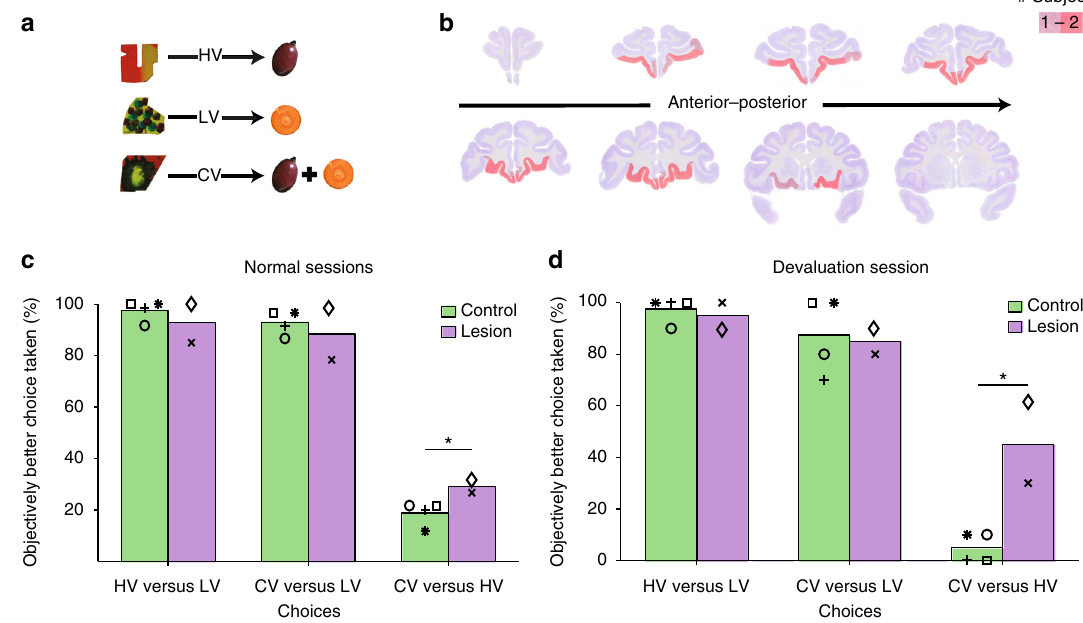
Fig. 1 Behavioral data — experiment 1. a Example stimulus-reward associations for HV, LV, and CV options. b Red shading indicates area of vmPFC/OFC lesion present in one or both animals. c Frequency of choosing objectively better of the two options. Controls (green bars) as well as lesioned animals (purple bars) preferred HV- to LV- stimuli and CV- to LV-stimuli. For the HV vs. CV decision, strikingly, controls preferred HV-stimuli, receiving only a subset of the rewards that CV-stimuli would have offered. However, macaques with vmPFC/OFC lesions did not prefer CV- to HV-stimuli as much as controls (right). d The pattern of results was replicated, including group difference in HV vs. CV decisions, even after HV vs. CV decisions were made easier by satiating animals with LV rewards prior to